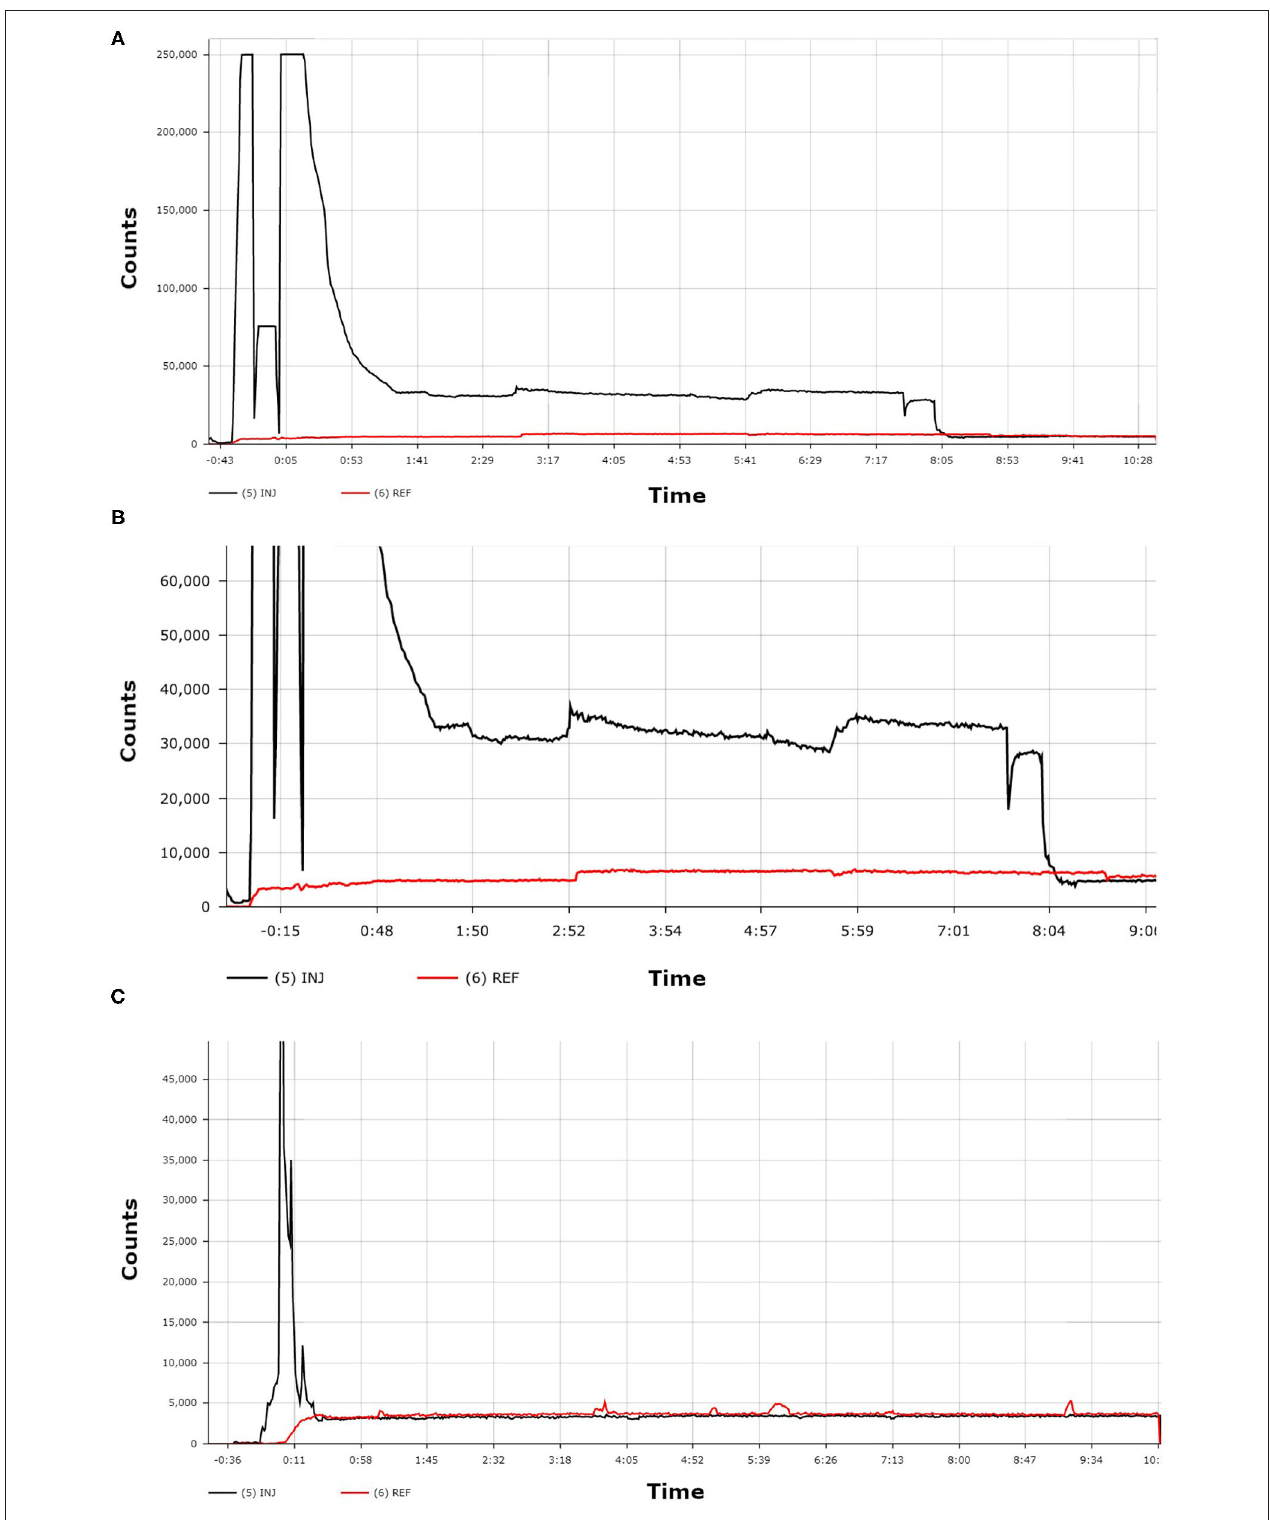
FIGURE 2 | The first TAC (A) shows the patient’s administration with 99m Tc-MDP. A zoomed-in view of this same TAC (B) more clearly shows the dramatic difference between the counts from the injection arm sensor curve (black line) and the counts from the reference arm sensor curve (red line). The third TAC (C) was acquired from a different patient and shows an ideal administration where the injection arm sensor curve (black line) and the reference arm sensor curve (red line) reached equilibrium within seconds.